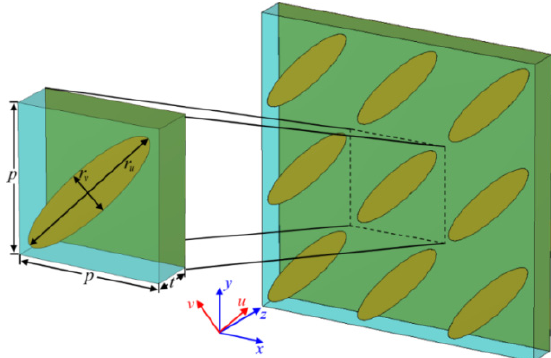
Figure 1. Schematic diagram of the terahertz metasurface.